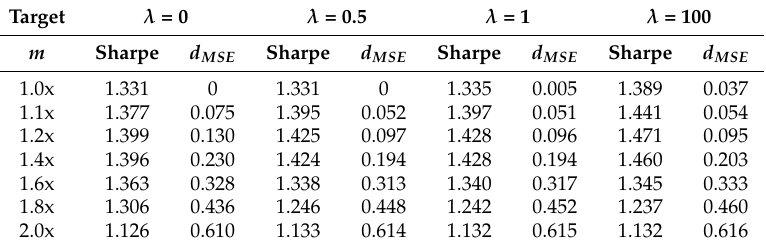
Table 4. In-Sample MSE Distance to RP with increasing λ —2009–2018.